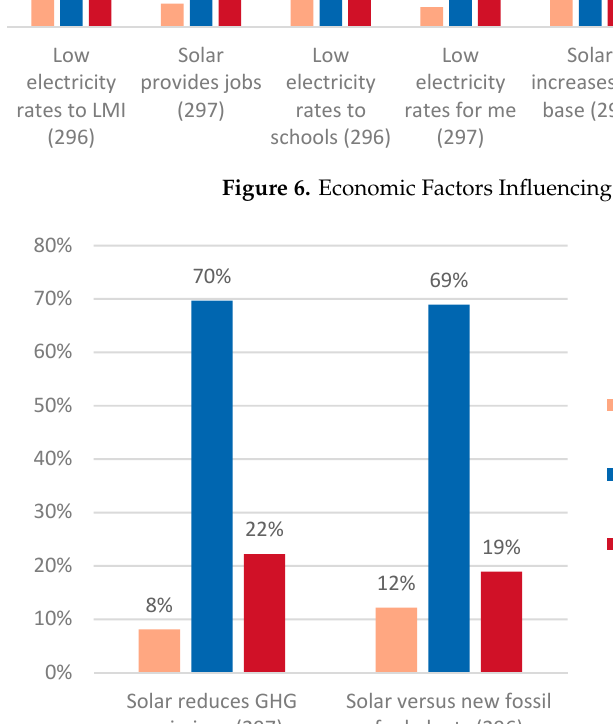
Figure 7. Environmental Factors Influencing Support.